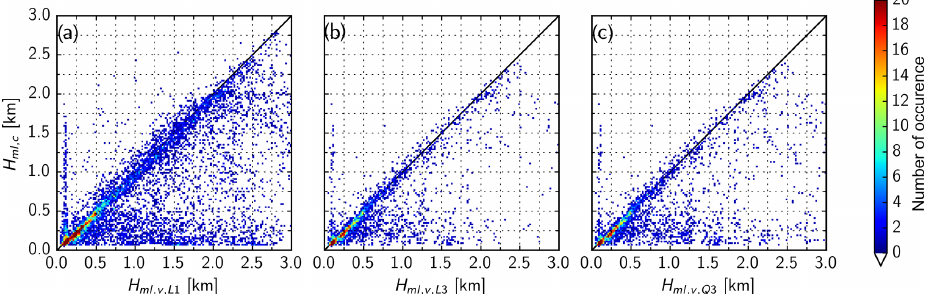
Figure 3. Comparison of MLH (in km) retrieved by COBOLT ( H ml , c ) and different BL-VIEW approaches during the BAERLIN2014 campaign. (a) H ml , v , L1 from L1 criterion, (b) H ml , v , L3 from L3 criterion and (c) H ml , v , Q3 from Q3 criterion. The number of occurrence is color